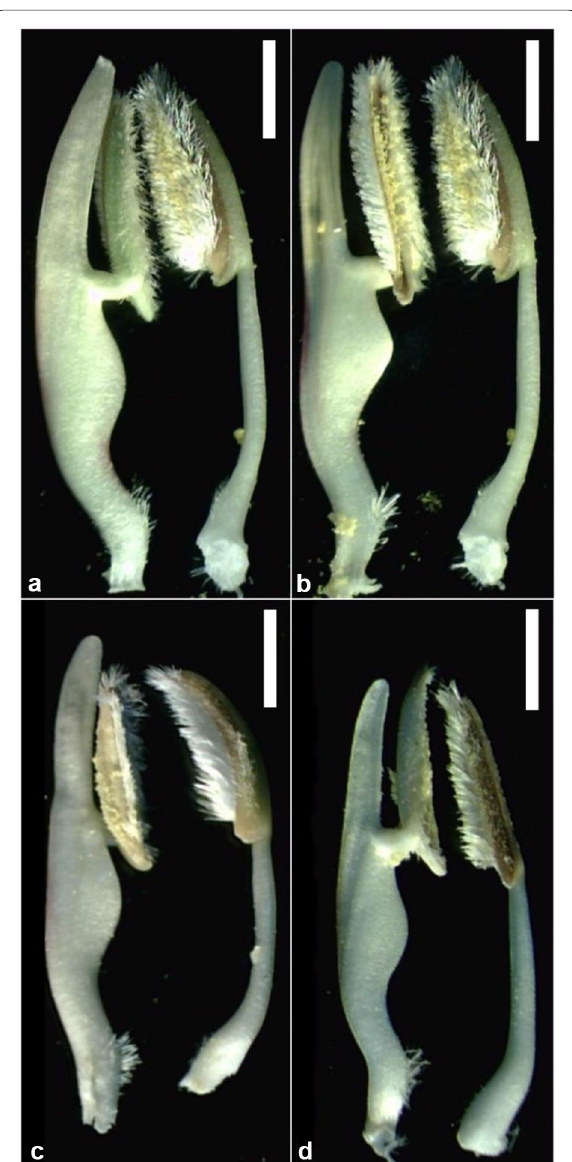
Fig. 4 Dimorphic stamens with “knee‑like” appendages on the filaments from Blepharis plants collected from northern and southern sampling sites in Jordan. a , b Stamens of a plant from the Dead Sea region (northern population). c , d Stamens of a plant from the Wadi al Yutm (southern population). Each stamen pair represents an anterior (left) and a posterior (right) stamen. Scale bars 2 = total polymorphic markers produced. Data obtained by scoring ISSR profiles were used to calculate a similarity matrix using Jaccard’s coefficients. Similarity values were used for subsequent cluster analyses. Sequential agglom- erative hierarchical non-overlapping (SAHN) clustering was employed using unweighted pair group method with